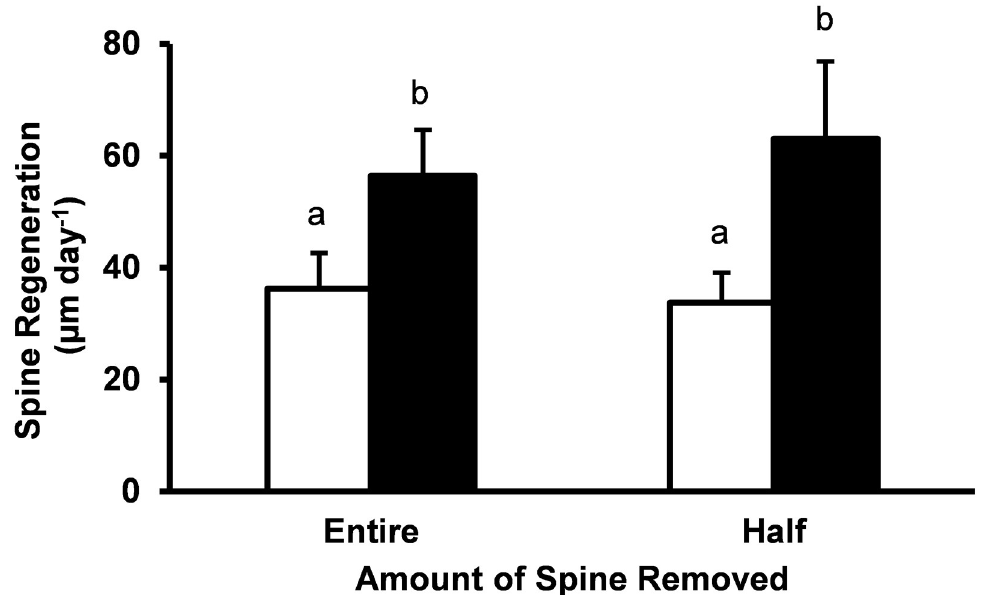
Fig 1. Spine regeneration rate. Rate of spine regeneration ( μ m day -1 ) for spines cut at the base (entire) or at half the spine length (half) after 21 days of feeding ad libitum (white bars) or fasted (black bars). Mean values ± standard error are shown (n = 9 for each treatment group). Fed animals had significantly lower spine regeneration rates for whole and half spine removal ( P = 0.0421, t = 2.772; P = 0.00752, t = 3.0871